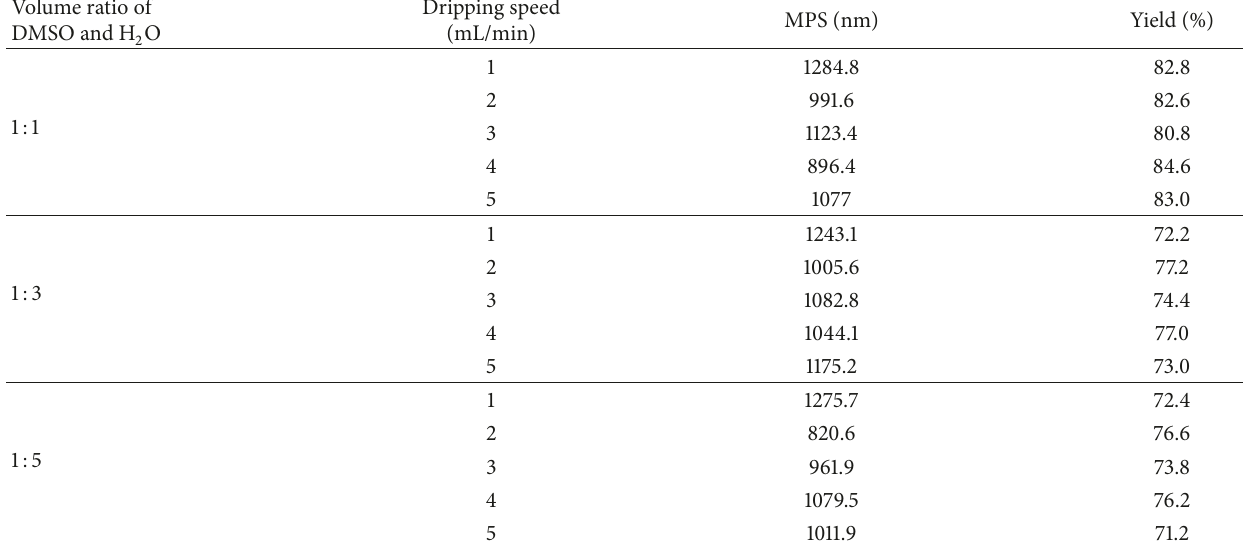
Table 2: The factors of orthogonal and experimental